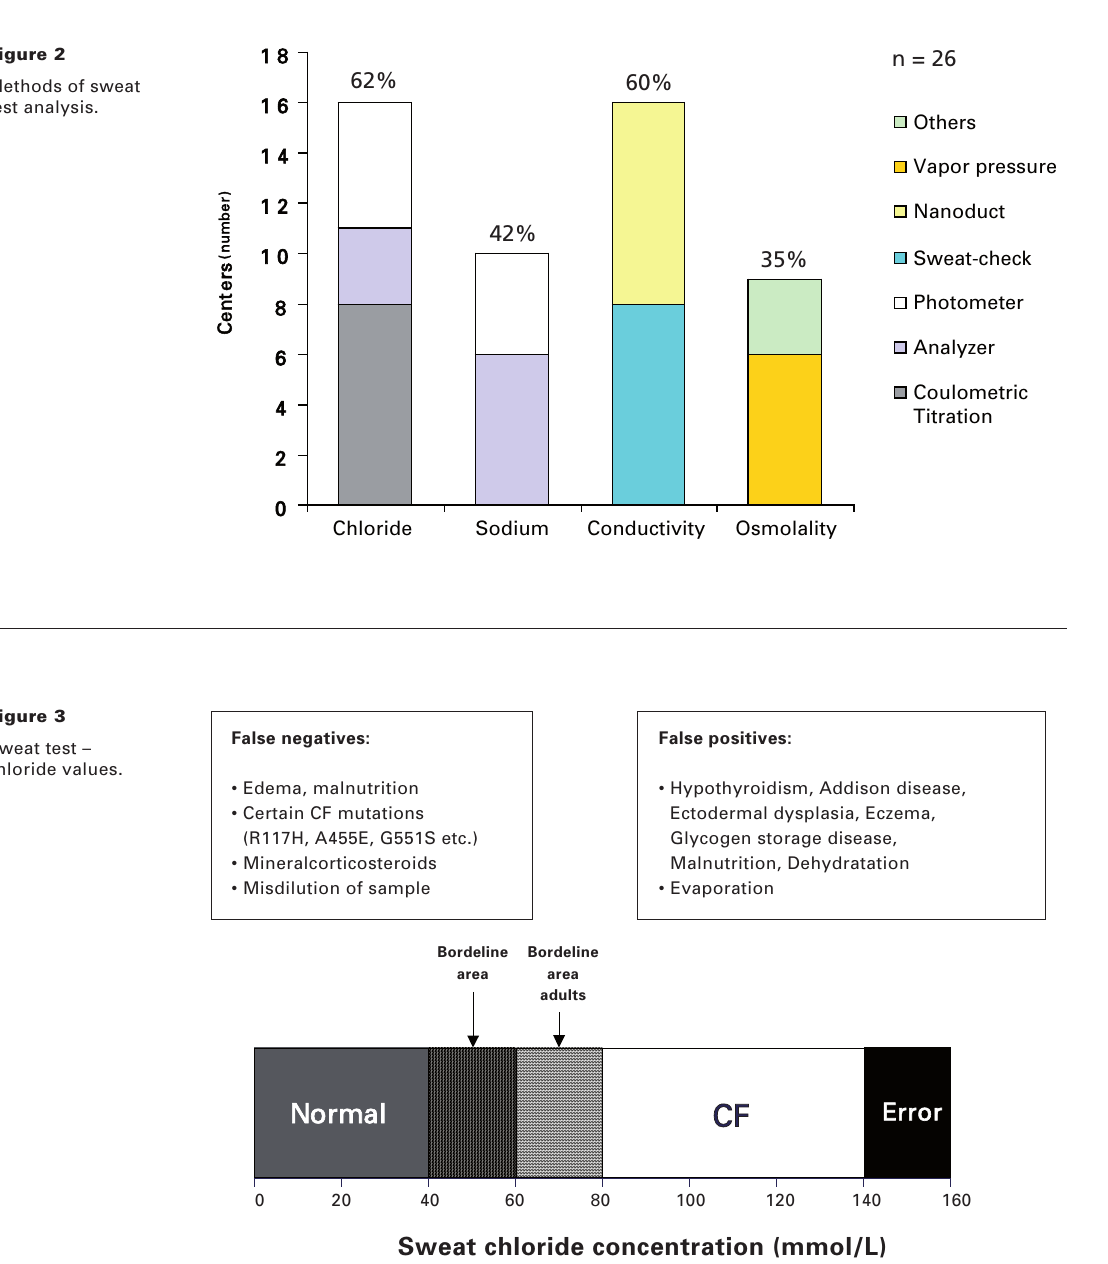
Figure 2 Methods of sweat test analysis.